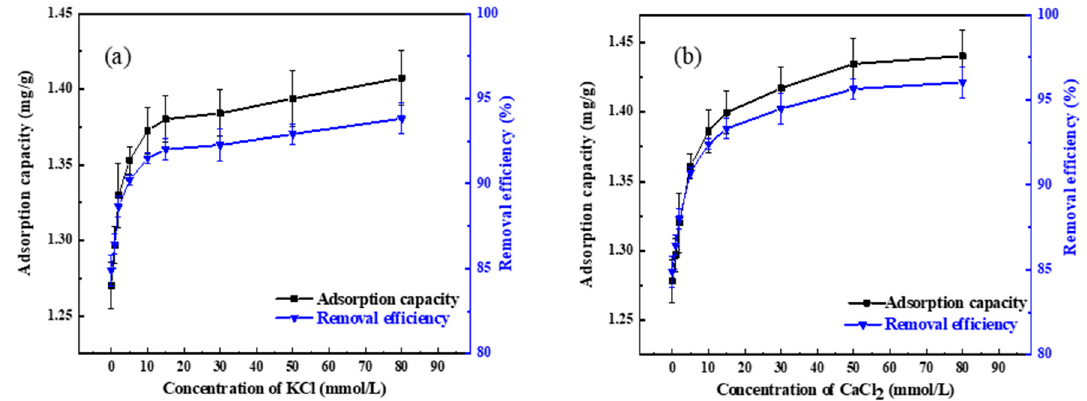
Figure 4. Variations in the adsorption capacity of coke powder and quinoline removal efficiency in the absence and presence of ( a ) KCl and ( b ) CaCl 2 (the error bars represent the 95% confidence interval of the average values).